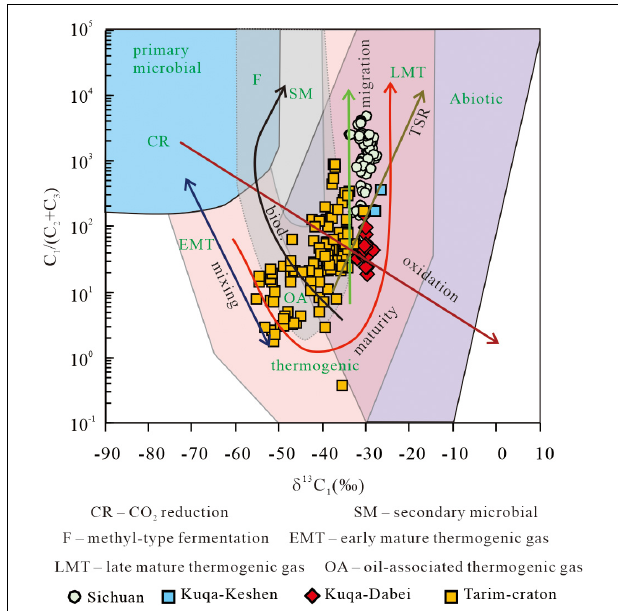
FIGURE 4 | Genetic diagram of C 1 /(C 2 + C 3 ) vs. δ 13 C 1 of gases from Dabei and Keshen gas fields in the Kuqa depression, craton area of Tarim Basin and Sichuan Basin, China (Milkov and Etiope, 2018). Data source see section “Samples and Methods” in the text.